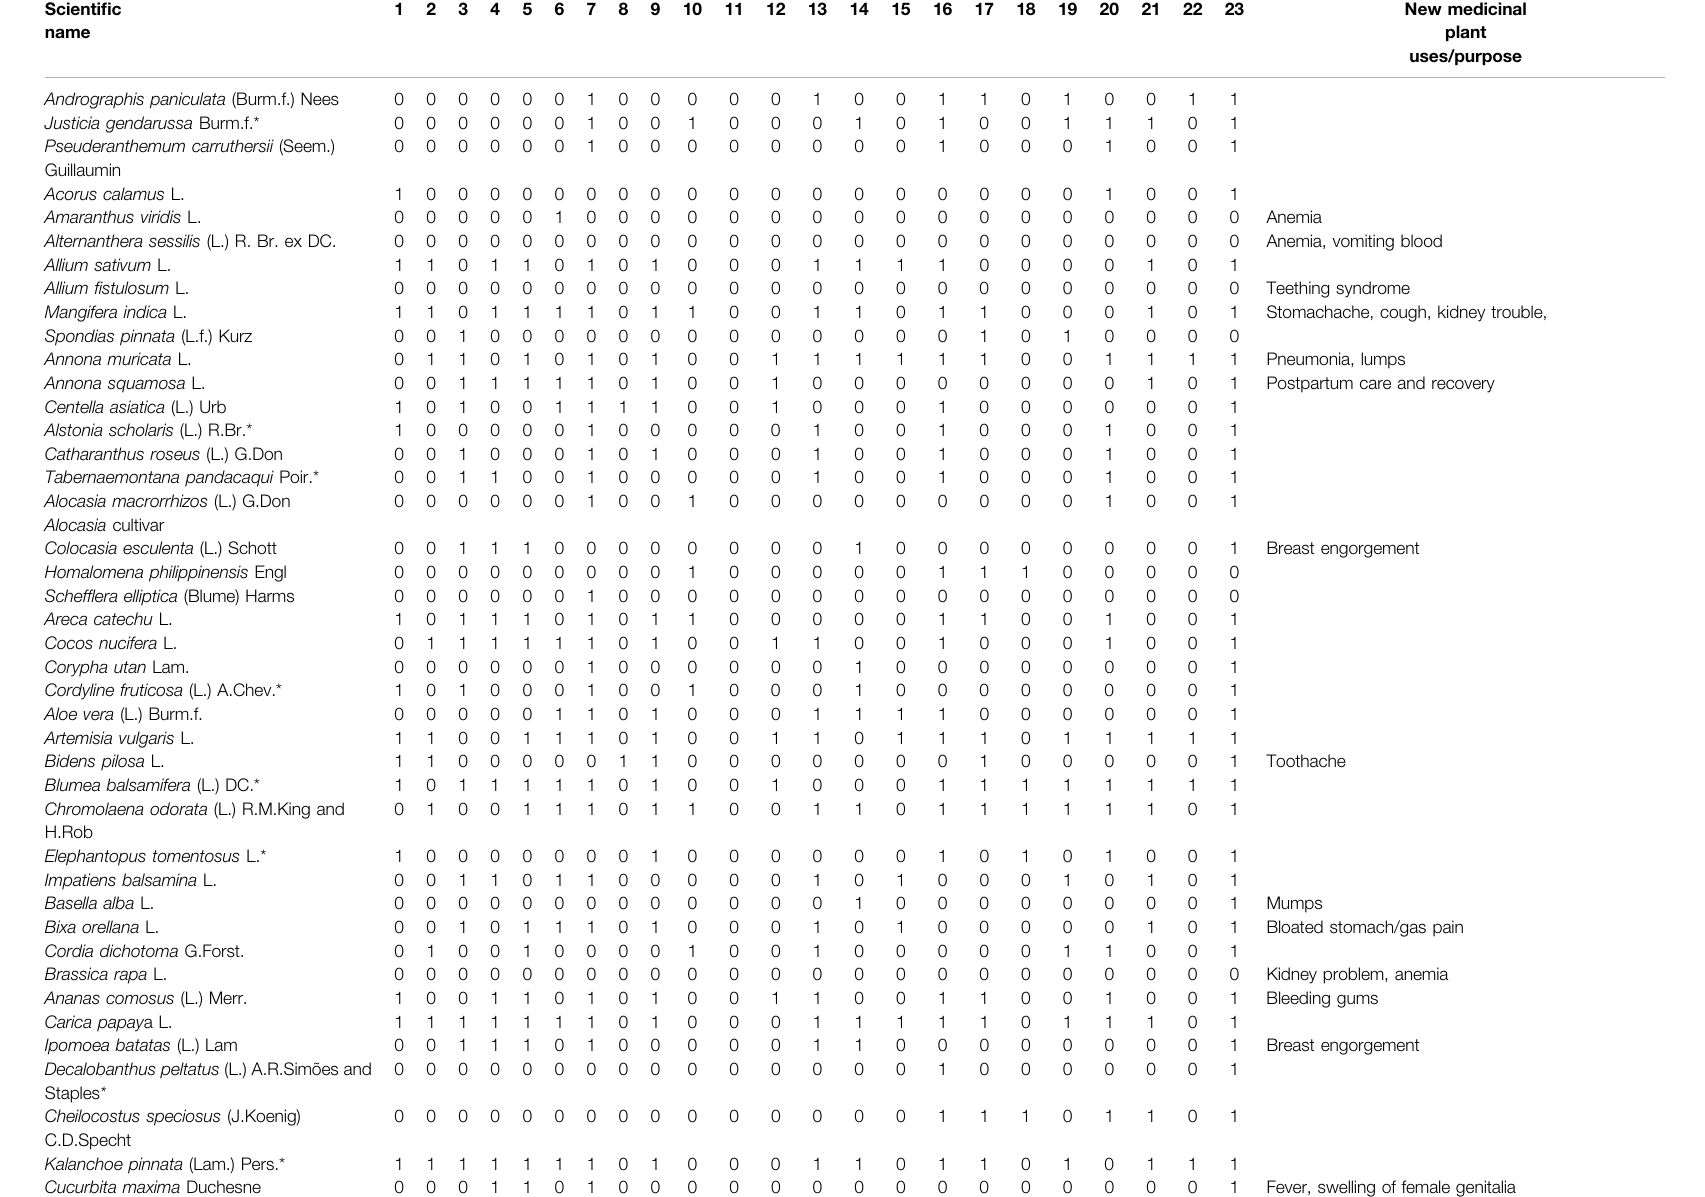
TABLE 5 | Comparative presence-absence matrix of the medicinal plants used by the Panay Bukidnon with other ethnobotanical